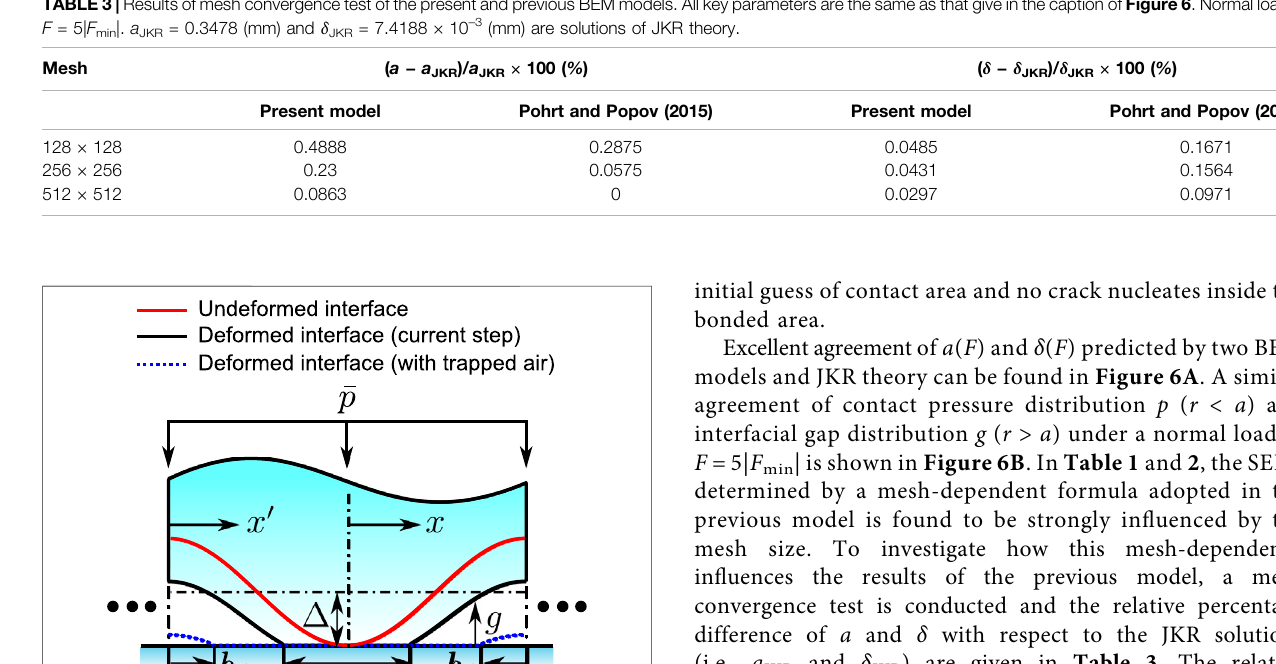
Frontiers in Mechanical Engineering |